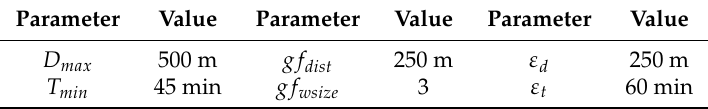
Table 4. Parameters set for the CDS and map builder. Parameter Value Parameter Value Parameter Value D max 500 m gf wsize ε t 60 min